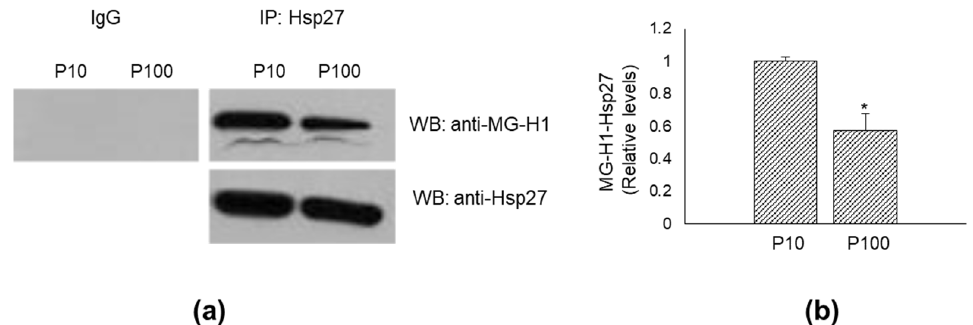
Figure 5. Heat shock protein (Hsp)27 is a MG-H1-modified protein in HASC-P10 and HASC-P100 EVs. ( a ) Lysates from HASC-P10 and HASC-P100 EVs were immunoprecipitated with protein G agarose-coupled anti-Hsp27 (IP: Hsp27) and subjected to Western blotting (WB) with anti-MG-H1 antibody. Blots were then stripped and re-probed with anti-HSP27 antibody (WB: anti-Hsp27) to ensure equal immunoprecipitation of HSP27 proteins. IgG was used as negative control for immunoprecipitation; ( b ) the histogram indicates mean ± SD of MG-H1-Hsp27 relative to total Hsp27 in IP samples, as quantified by densitometric analysis of WB bands. Normalized optical density values were expressed as relative protein level units. * p < 0.01 vs. HASC-P10.